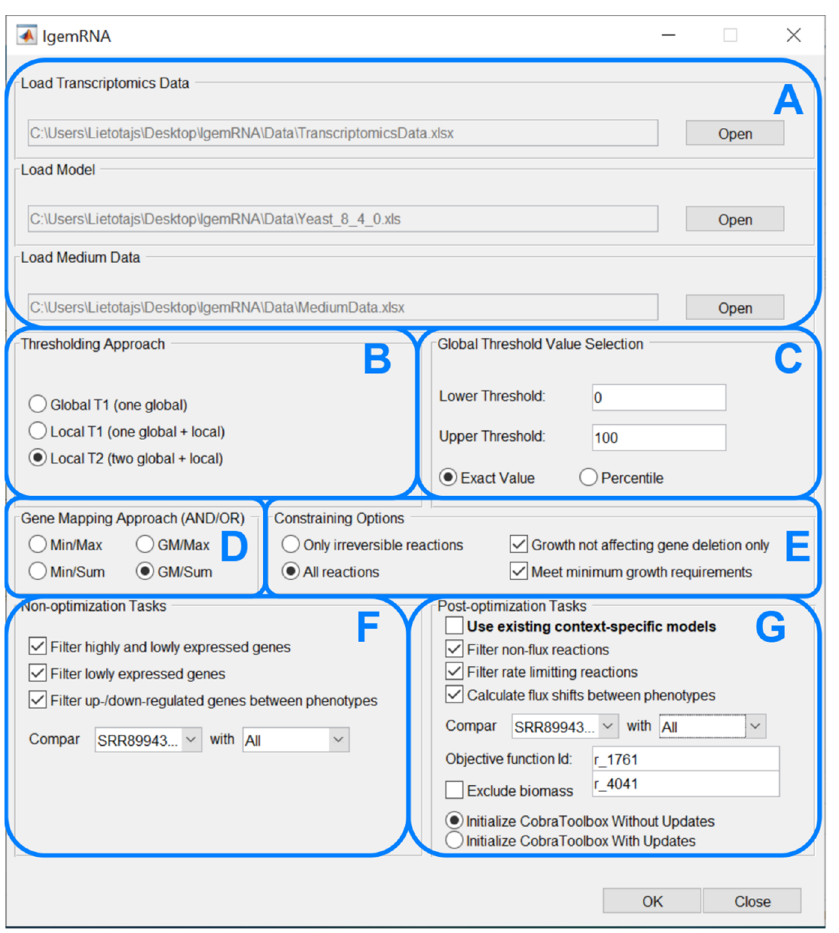
Figure 3. IgemRNA’s graphical interface. ( A ) Input data window, ( B ) Thresholding window, ( C ) Global thresholding value window, ( D ) Gene mapping window, ( E ) Reactions and transcriptomics data mapping window, ( F ) Non—optimization task window, ( G ) Post—optimization window.